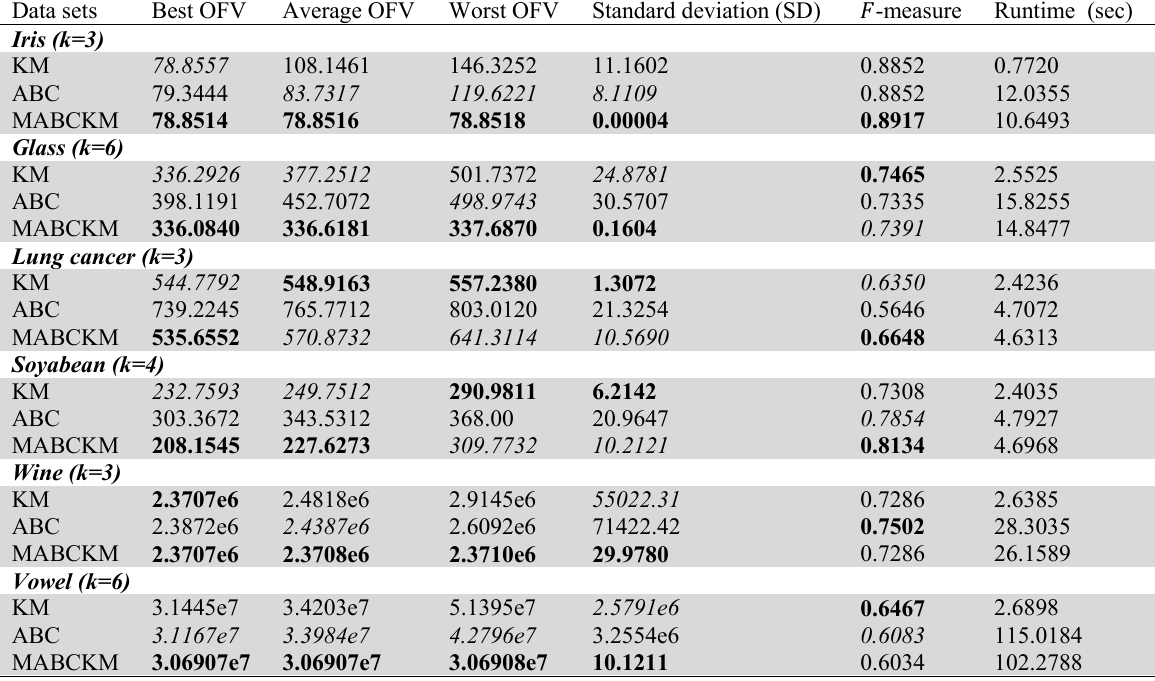
Results obtained by various algorithms on different data sets. Bold face indicates the best and italic face the second best result